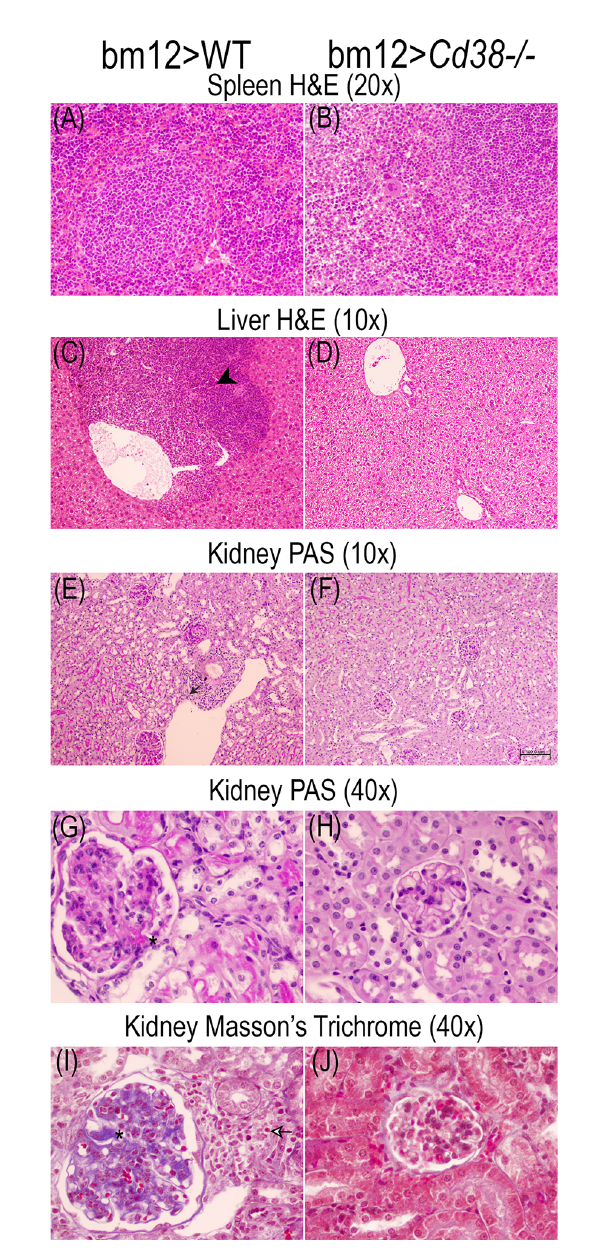
FIGURE 10 | Representative microphotographs of the histological studies performed on the spleen, liver, and kidney 3- m m sections at 4 weeks of the adoptive transfer of spleen cells from female bm12 to female WT (left panels) or Cd38 − / − (right panels) mice. (A, B) Spleen, (C, D) liver, and (E – J) kidney. (A – D) Spleen and liver tissue sections were stained with H&E. ( E – H ) Kidney tissue sections were stained with PAS. (I, J) Kidney sections were stained with Masson ’ s trichrome. Images were taken with a BH2 Olympus microscope. (A, B) ×20 magni fi cation; (C – F) ×10 magni fi cation; (G – J) ×40 magni fi cation. (F) Scale bar: 50 m m. Note in the liver from WT cGVHD mice the presence of moderate/severe perivascular chronic in fl ammatory in fi ltrate [black head arrow in (C) ]. Note in the kidney of WT cGVHD mice the presence of in fl ammatory in fi ltrate [small black arrow in (E) ], periglomerular chronic in fl ammatory in fi ltrate [black and white arrow in (I) ], and increased glomerular size with increased mesangial matrix [asterisks in (G) and (I) ].